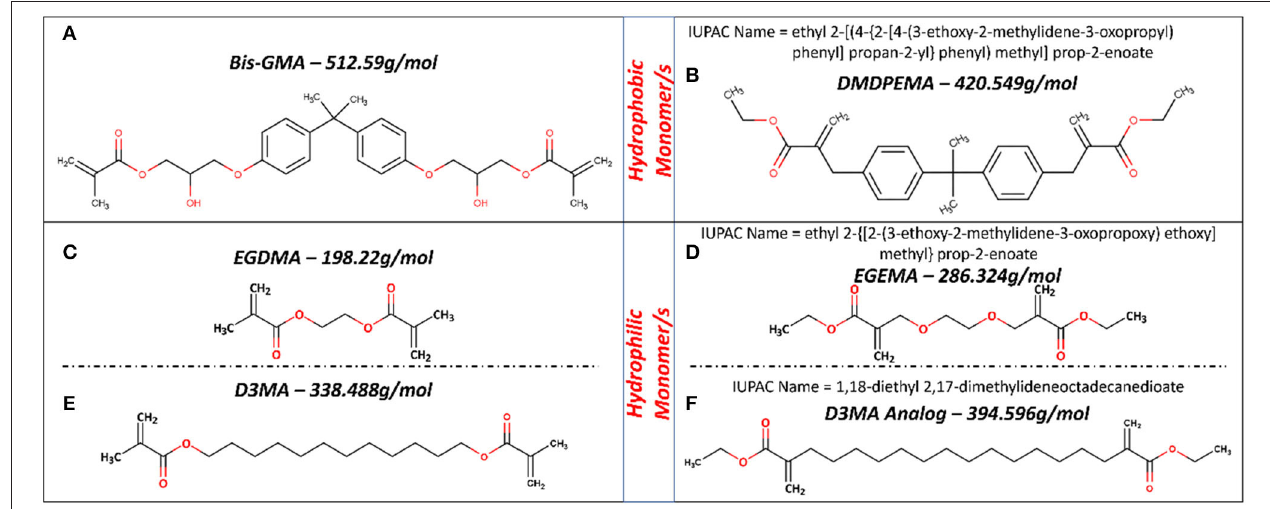
FIGURE 5 | Molecular structure for hydrophobic (A,B) and hydrophilic (C–F) monomers used in dental formulations and their analog with flipped ester group design. Figures in (C,D) based on figures in ( 28, 30,